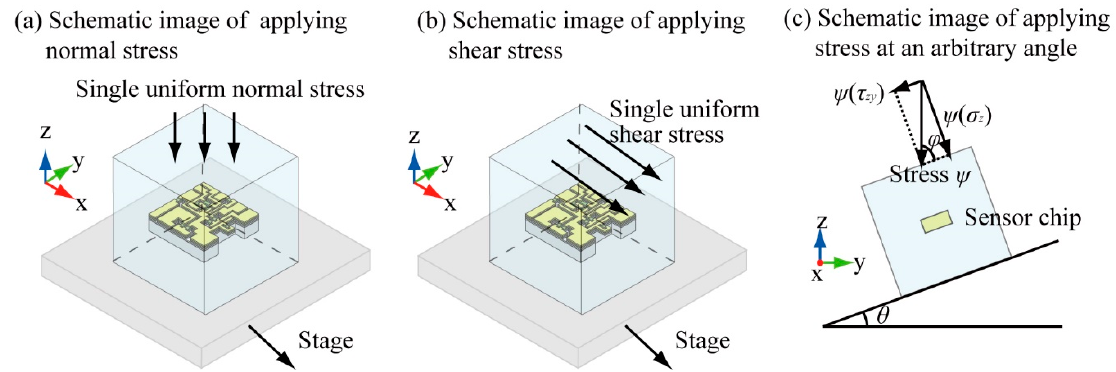
Figure 10. Schematic image of the experimental setups. ( a ) setup to calibrate normal stresses, ( b ) setup to calibrate shear stresses, and ( c ) setup to apply a shear stress at an arbitrary angle.